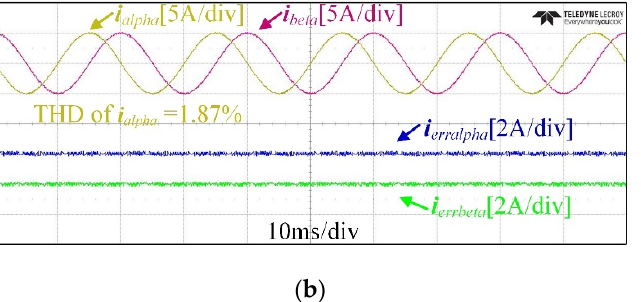
Figure 12. Experimental waveforms comparisons when L / L 0 = 2 ( i ref = 5A). ( a ) Waveforms under the conventional MPC scheme. ( b ) Waveforms under the proposed MFPC scheme.